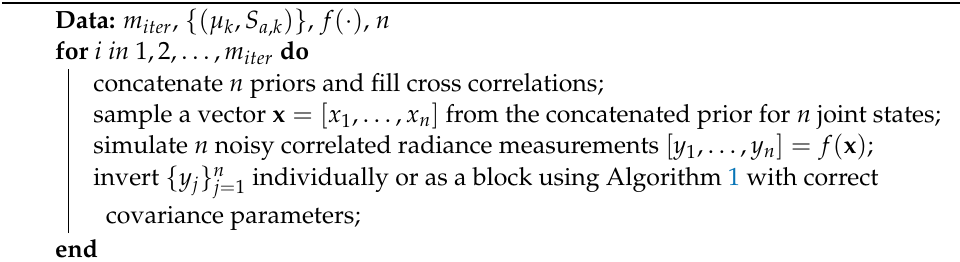
Algorithm 2: Simulation Procedure: generate n pixels, compute correlated radi- ances, and invert. Repeat m iter times.